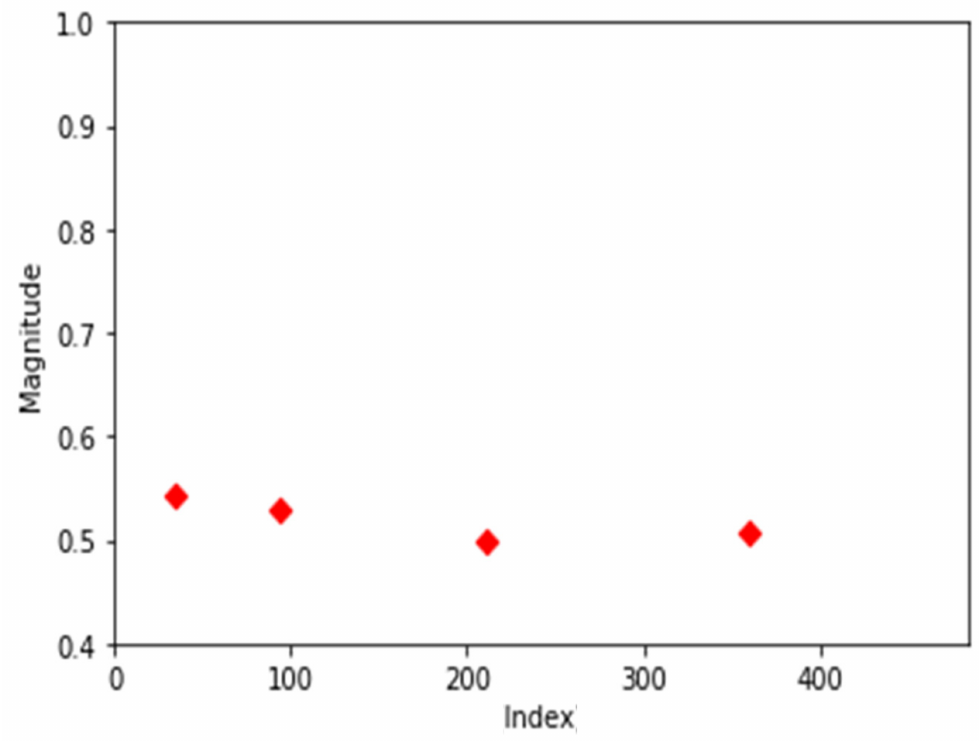
Figure 8. Center points of third-order error data.